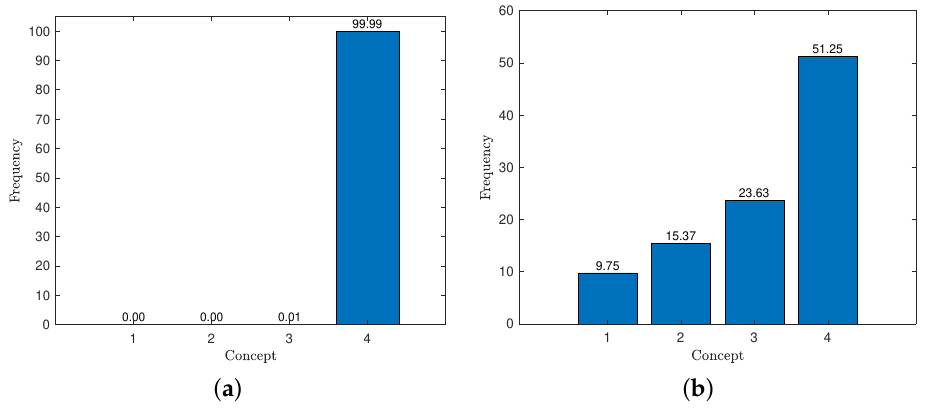
Figure 5. Frequency of dominance of concepts (in %) obtained varying ( a ) the weights with ∼ U ( γ k ) ; ( b ) the scores ∆ k ) . Legend: Concept 1—Reference; Concept 2— Techno w k ∼ N ( w l , s r l l l Slipper ; Concept 3— Star Slipper+ ; Concept 4— Diamond Slipper+ .